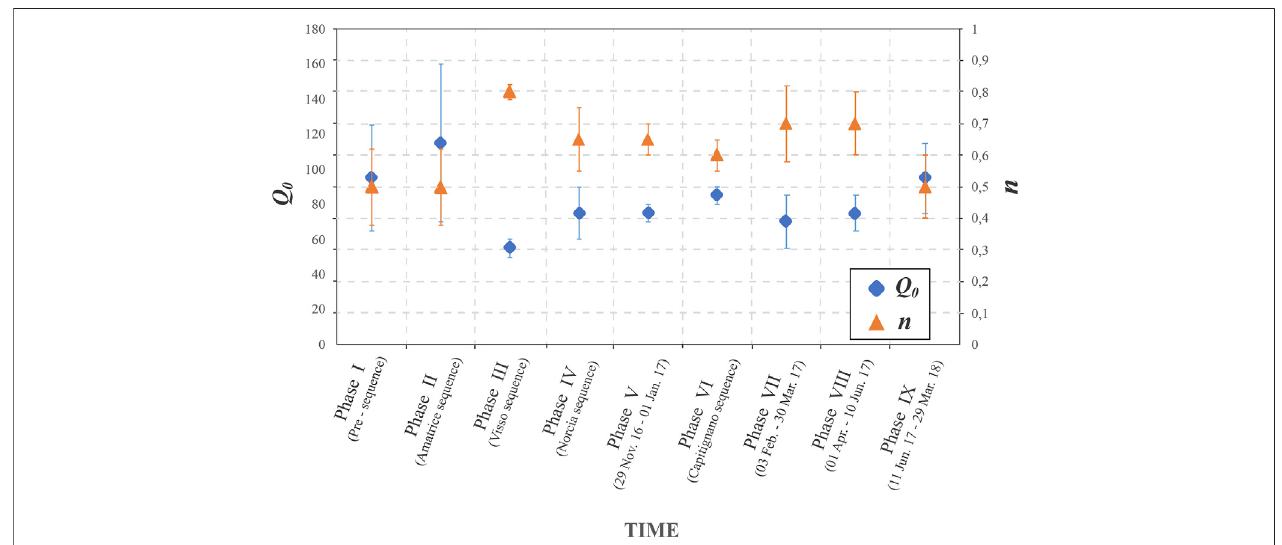
FIGURE 4 | Frequency-dependent Q as Q( f ) = Q 0 ( f / f ref ) n , f ref = 1 Hz. The Q 0 (blue dots) and the frequency dependence of the attenuation, n (orange triangles) and their standard errors as a function of nine time phases include Amatrice, Visso, and Norcia earthquake sequences (for the details see Table 1 ).